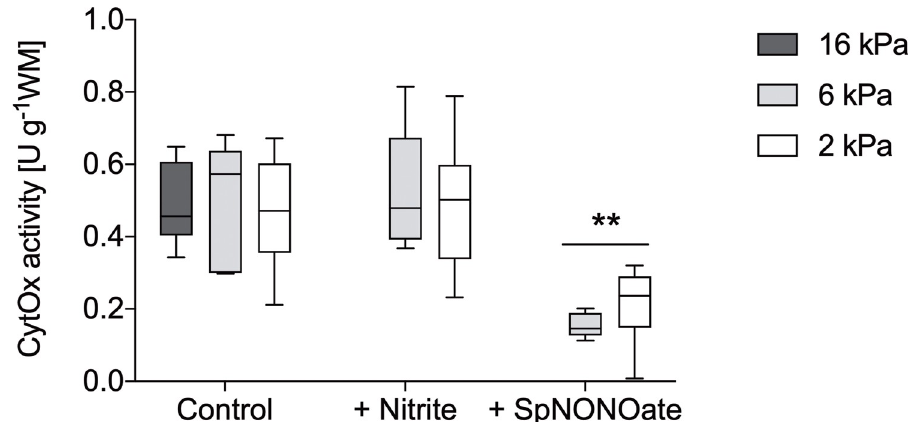
Fig 6. Activity of cytochrome- c -oxidase (CytOx) in gill tissues of Arctica islandica at three different p O 2 under control conditions (= without spermineNONONate), and in the presence of nitrite or spermineNONOate (SpNONOate). Mean ± SD, n = 6–10. �� CytOx activity differs significantly between control and spermineNONOate treatment (One-way ANOVA P < 0.0001, Tukey P < 0.05).